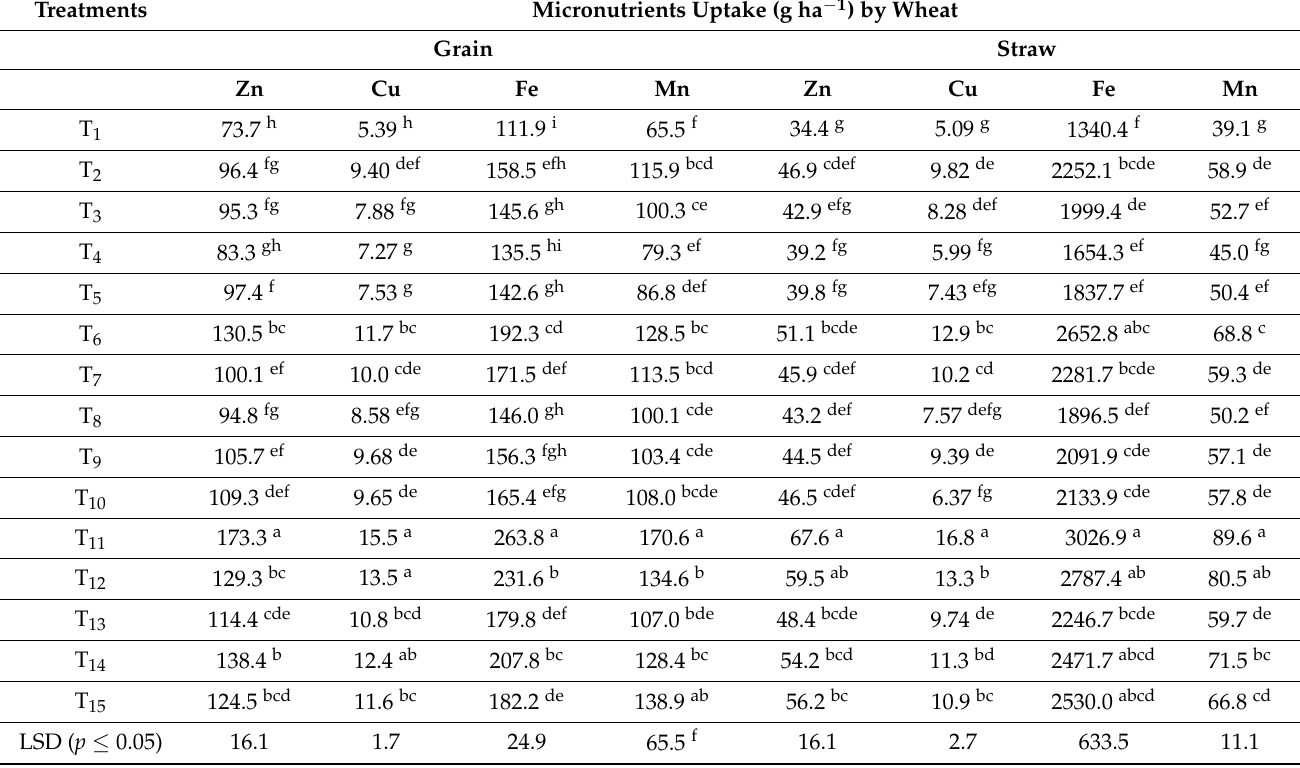
Table 5. Effect of different fertilizers and manures on Zn, Cu, Fe and Mn micronutrients uptake in grain and straw of